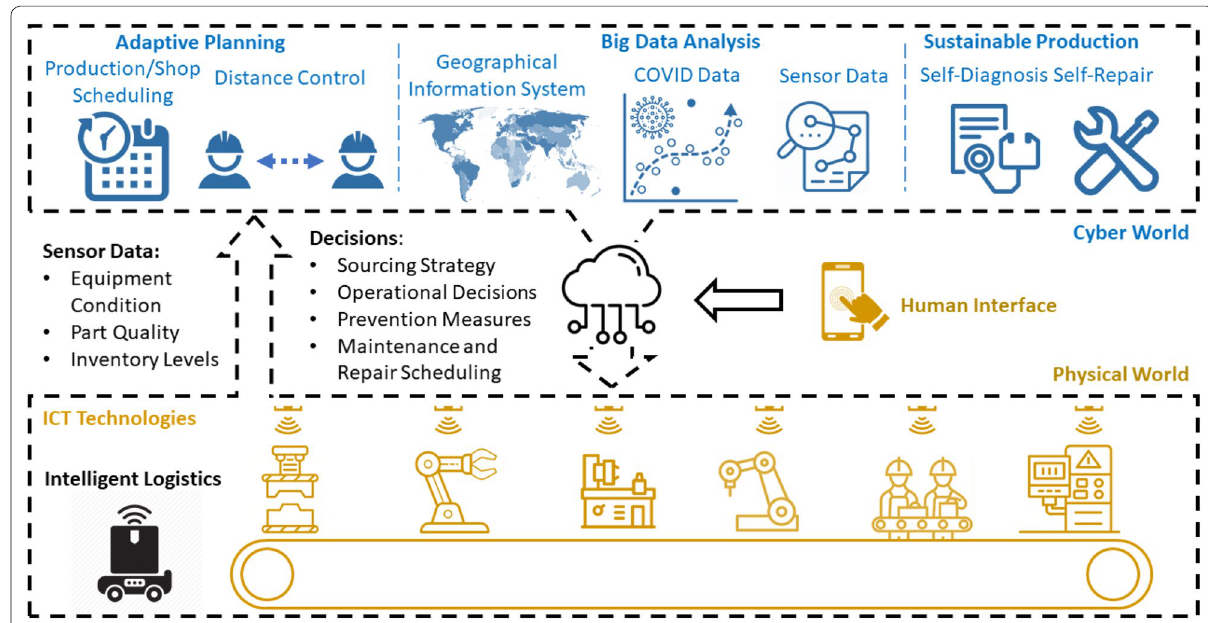
Figure 1 A framework of intelligent manufacturing systems in pandemic